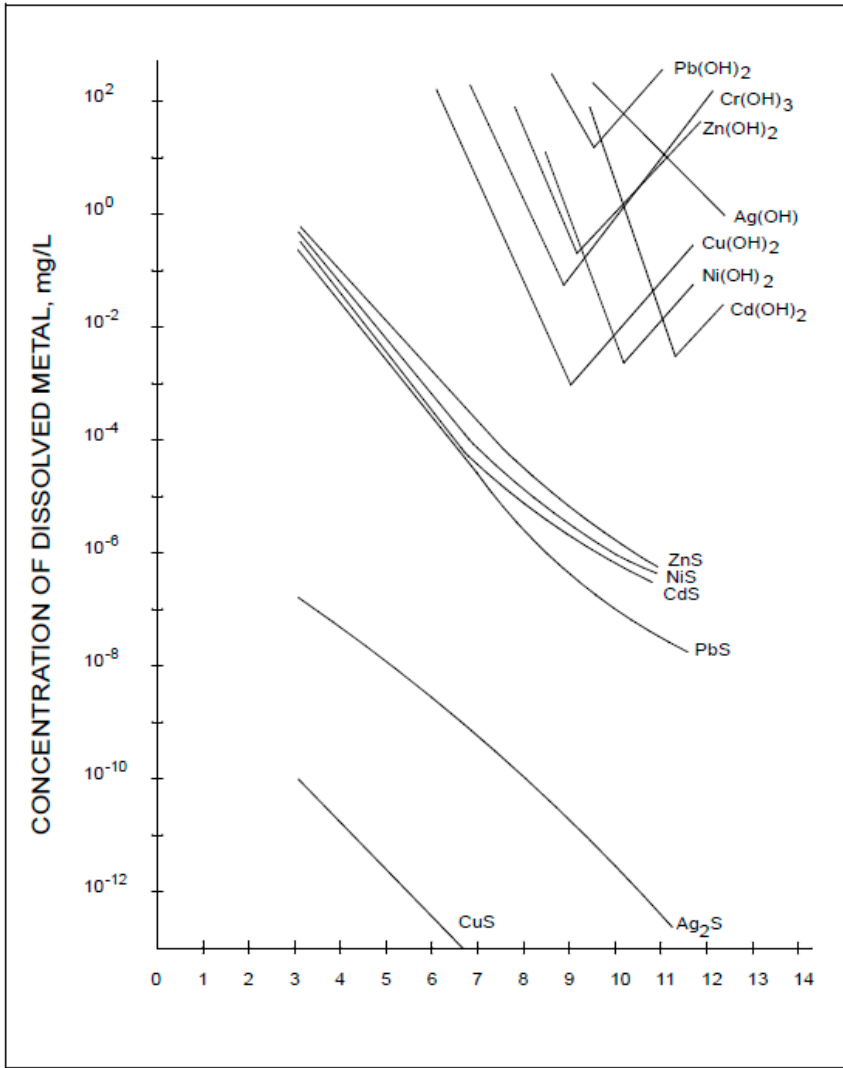
Figure 1. Precipitation pH and concentrations of hydroxides and sulphides.